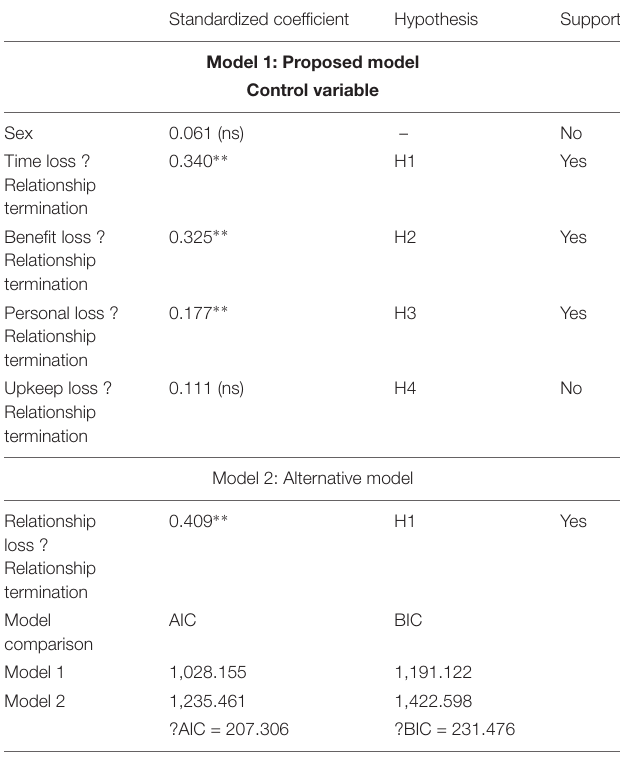
TABLE 4 | Results of estimated path